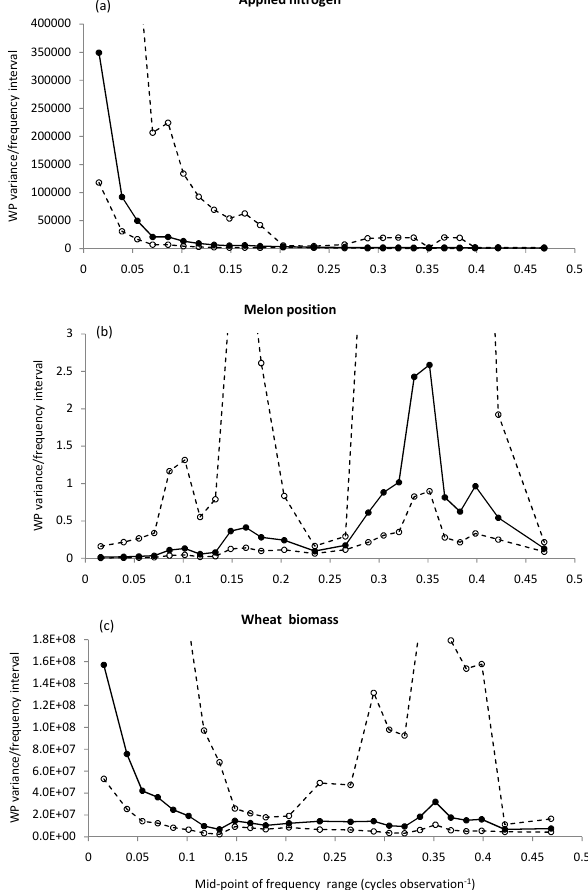
Fig. 7. The solid symbols show the standardized WP variances for (a) applied nitrogen, (b) melon position and (c) wheat biomass plot- ted against the mid-point of the corresponding frequency interval. The 95% confidence interval for each estimate are shown by the open symbols. The solid and dotted lines that join the symbols are to aid visual